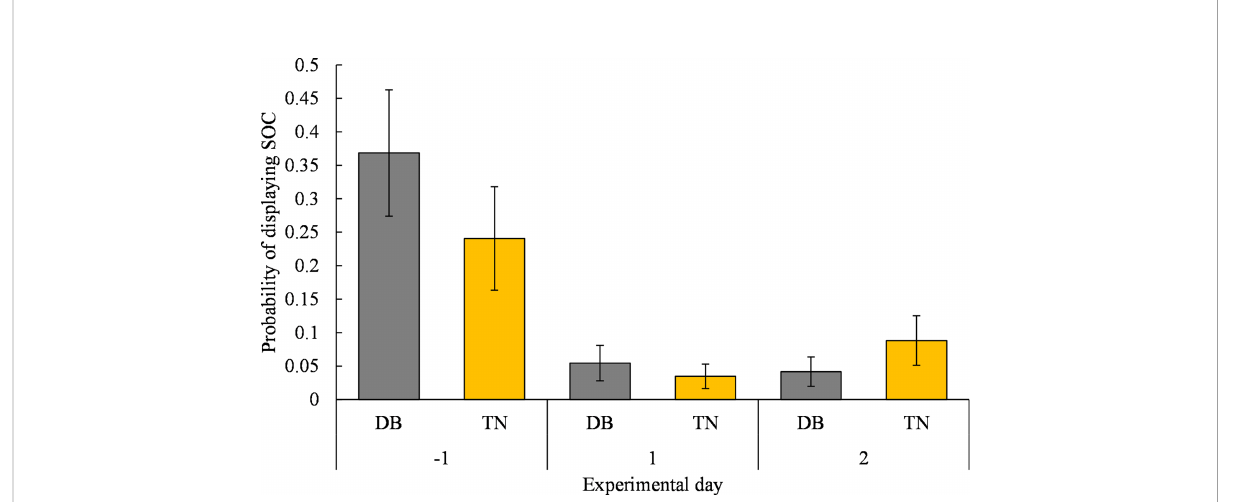
FIGURE 5 Probabilities of displaying social play (SOC) in DanBred pigs (DB; gray bars) or Topigs Norsvin TN70 pigs (TN; yellow bars) between 14:00 h and 22:00 h on days − 1, 1, and 2 relative to weaning. The bars represent probability, and the error bars indicate standard error. Estimates and standard error bars were back-transformed from the model using the inverse link